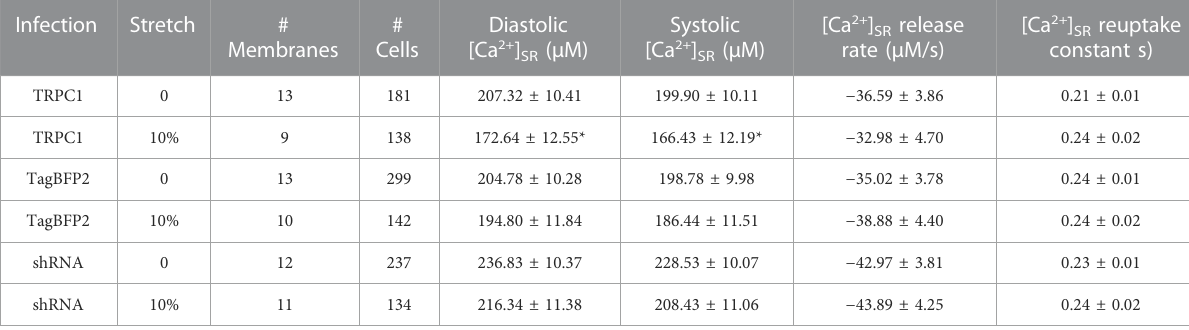
TABLE 2 Data extracted from calibrated [Ca 2+ ]SR transients of NRVMs.